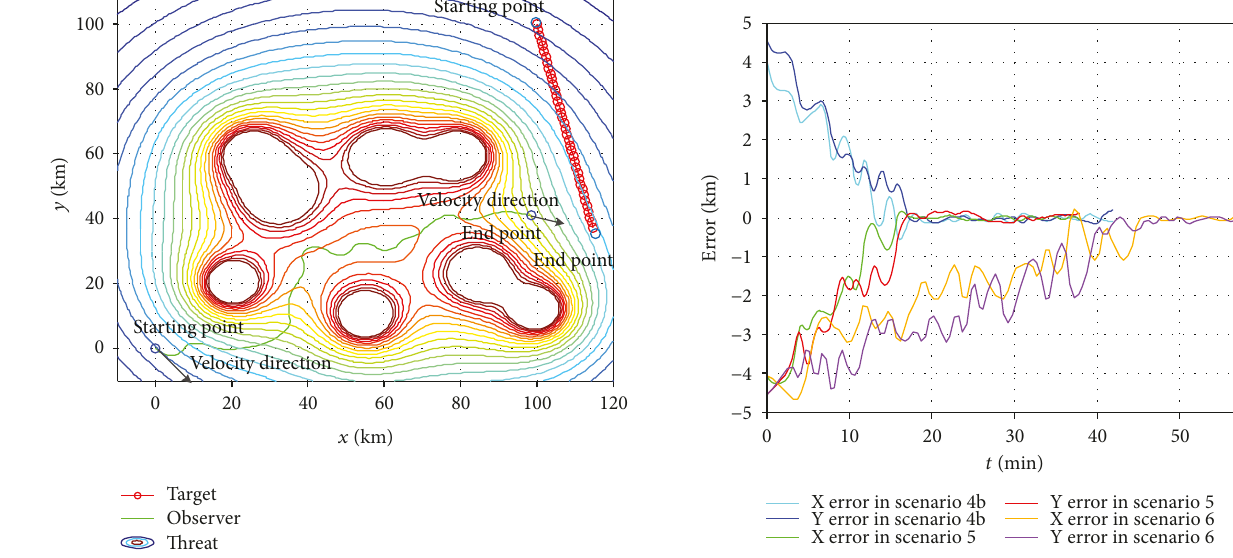
Figure 11: Target tracking results in scenarios 4b, 5,